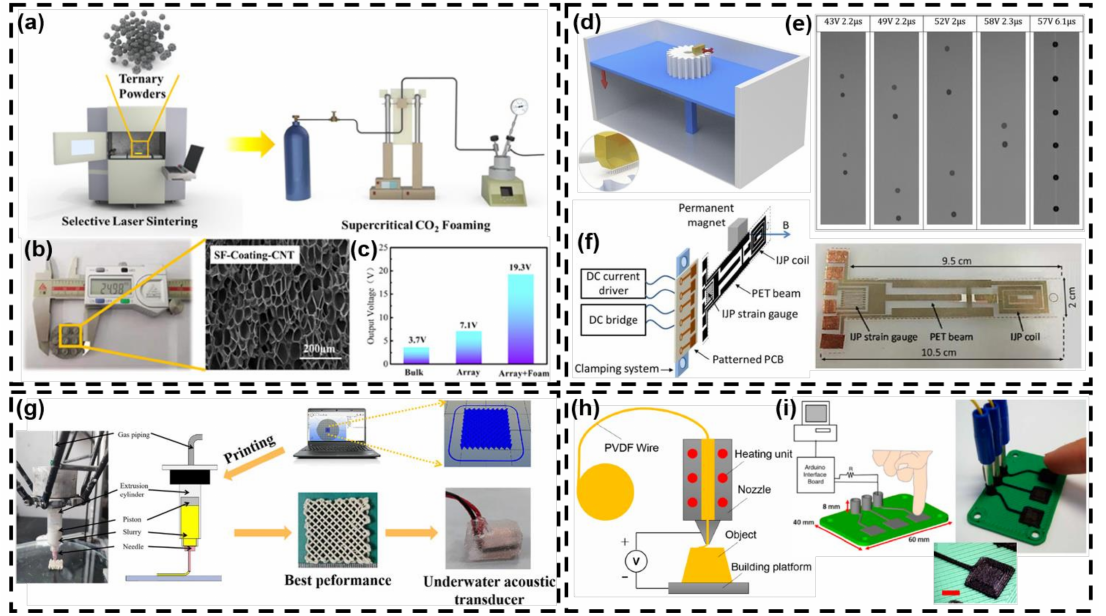
Figure 3. ( a ) Preparation of SLS-based porous foam. ( b ) Printed energy harvester and scanning elec- tron microscopy (SEM) image of pore morphologies. ( c ) Output of a piezoelectric energy harvester [26] (Copyright 2021, American Chemical Society). ( d ) IJP process with inset showing the printhead